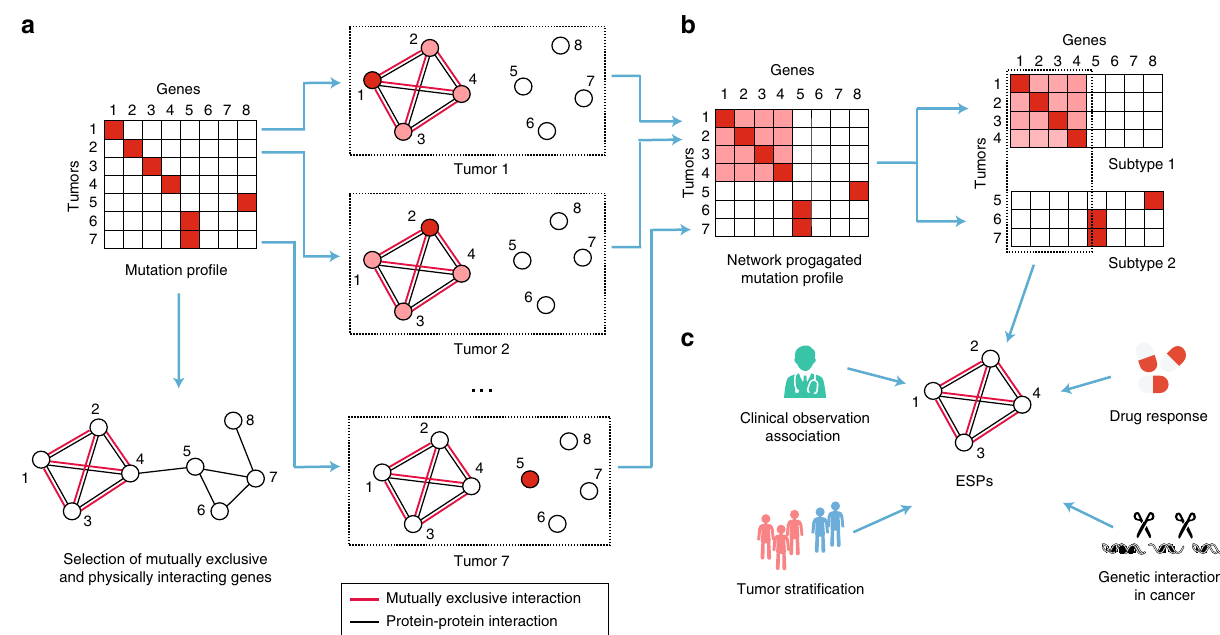
Fig. 3 Flowchart of ESP strati fi cation. a Selection of mutually exclusive protein – protein interactions and propagation of tumor somatic mutation pro fi les. Color scheme as for Fig. 1. b Clustering of network-propagated mutation pro fi les. c Detection of characteristic ESPs by comparing the propagated mutation pro fi les between